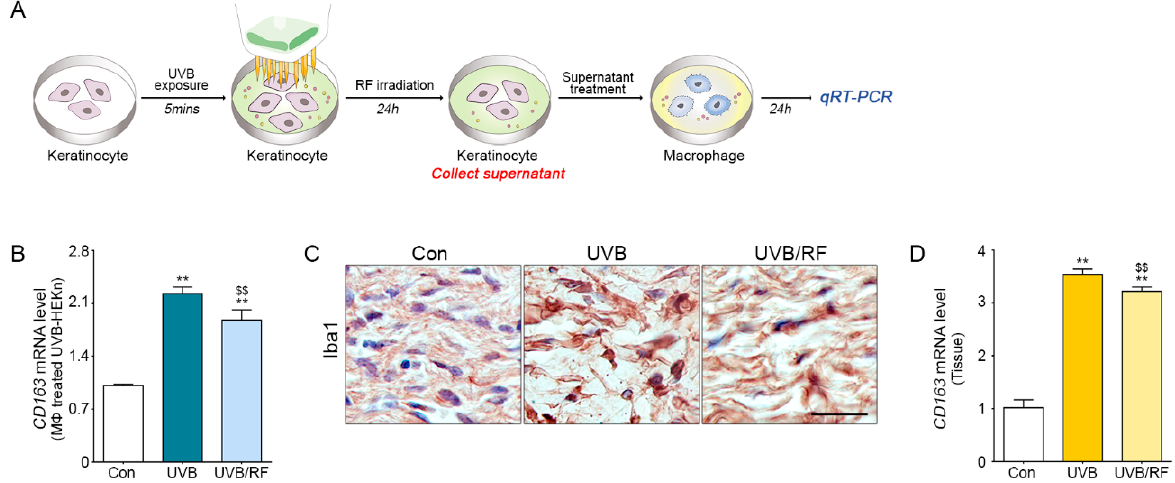
Figure 2. Inhibitory effects of RF irradiation on macrophage activation through keratinocyte modulation. ( A ) Diagram of an in vitro model to examine the effects of micro needling RF irradiation to UVB-radiated keratinocytes on the inflammatory response in macrophages. After exposing keratinocytes to UVB or UVB/RF, the cell culture supernatants were used to treat macrophages. ( B ) The mRNA levels of CD163, a dermal macrophage marker, were measured in macrophage-affected UVB-radiated keratinocytes. ( C ) The level of Iba1 protein, a macrophage activation marker, was detected in the skin dermis of UVB-radiated mice. ( D ) The mRNA levels of CD163 were detected in the skin of a UVB-radiated mouse. Scale bar = 100 µ m. Magnification, × 40. ** p < 0.01 vs. Con group; $$ p < 0.01 vs. UVB group. Results are presented as means ± standard deviations. Con, sham control; mRNA, messenger RNA; qRT-PCR, quantitative real-time polymerase chain reaction; RF, radiofrequency; UVB, ultraviolet B.